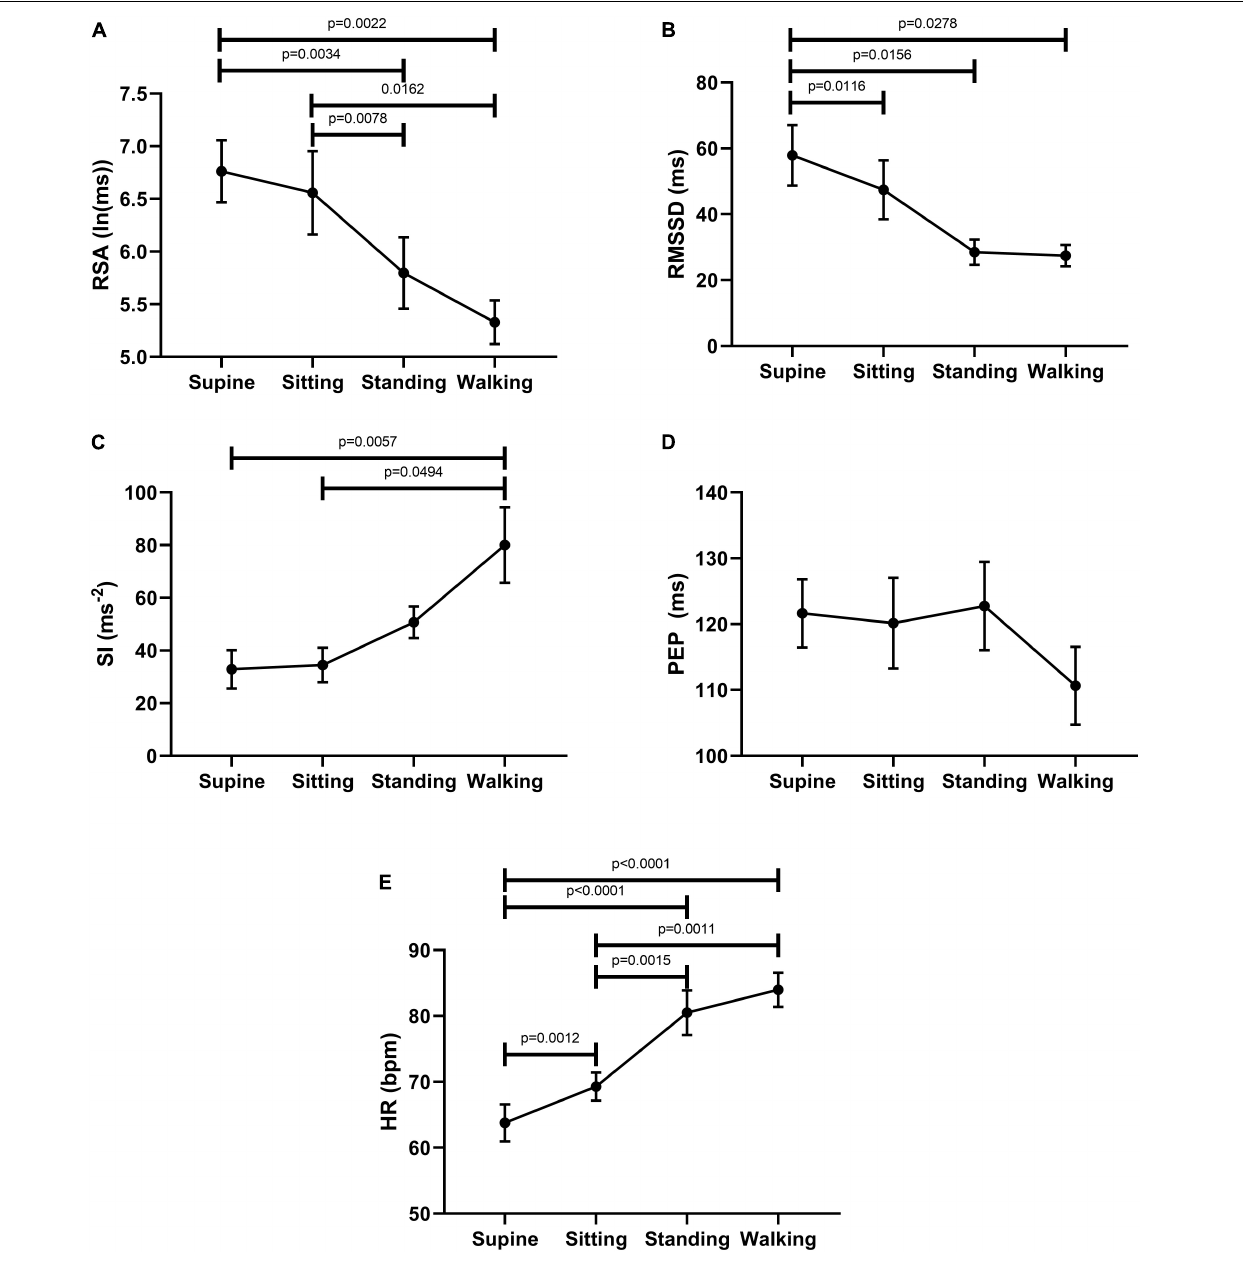
FIGURE 2 | Changes in autonomic activity in response to posture changes ( n = 11), Significance was assessed by one-way ANOVA with repeated measures and Bonferroni correction for (A,B,D,E) . Friedman test followed by Dunn’s multiple comparison tests was used to assess significance for (C) . (A) RSA declined upon standing and walking compared to the supine baseline position. (B) RMSSD declined upon standing and walking compared to the supine baseline position. (C) SI increased upon standing and walking compared to baseline position. (D) PEP decreased significantly only during walking. (E) Heart rate increases upon standing and walking compared to the supine baseline